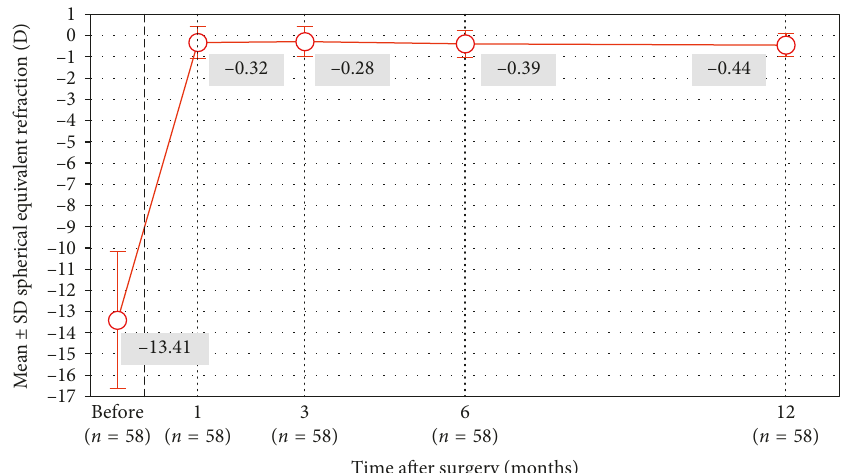
Figure 6: Mean manifest refraction throughout follow-up.